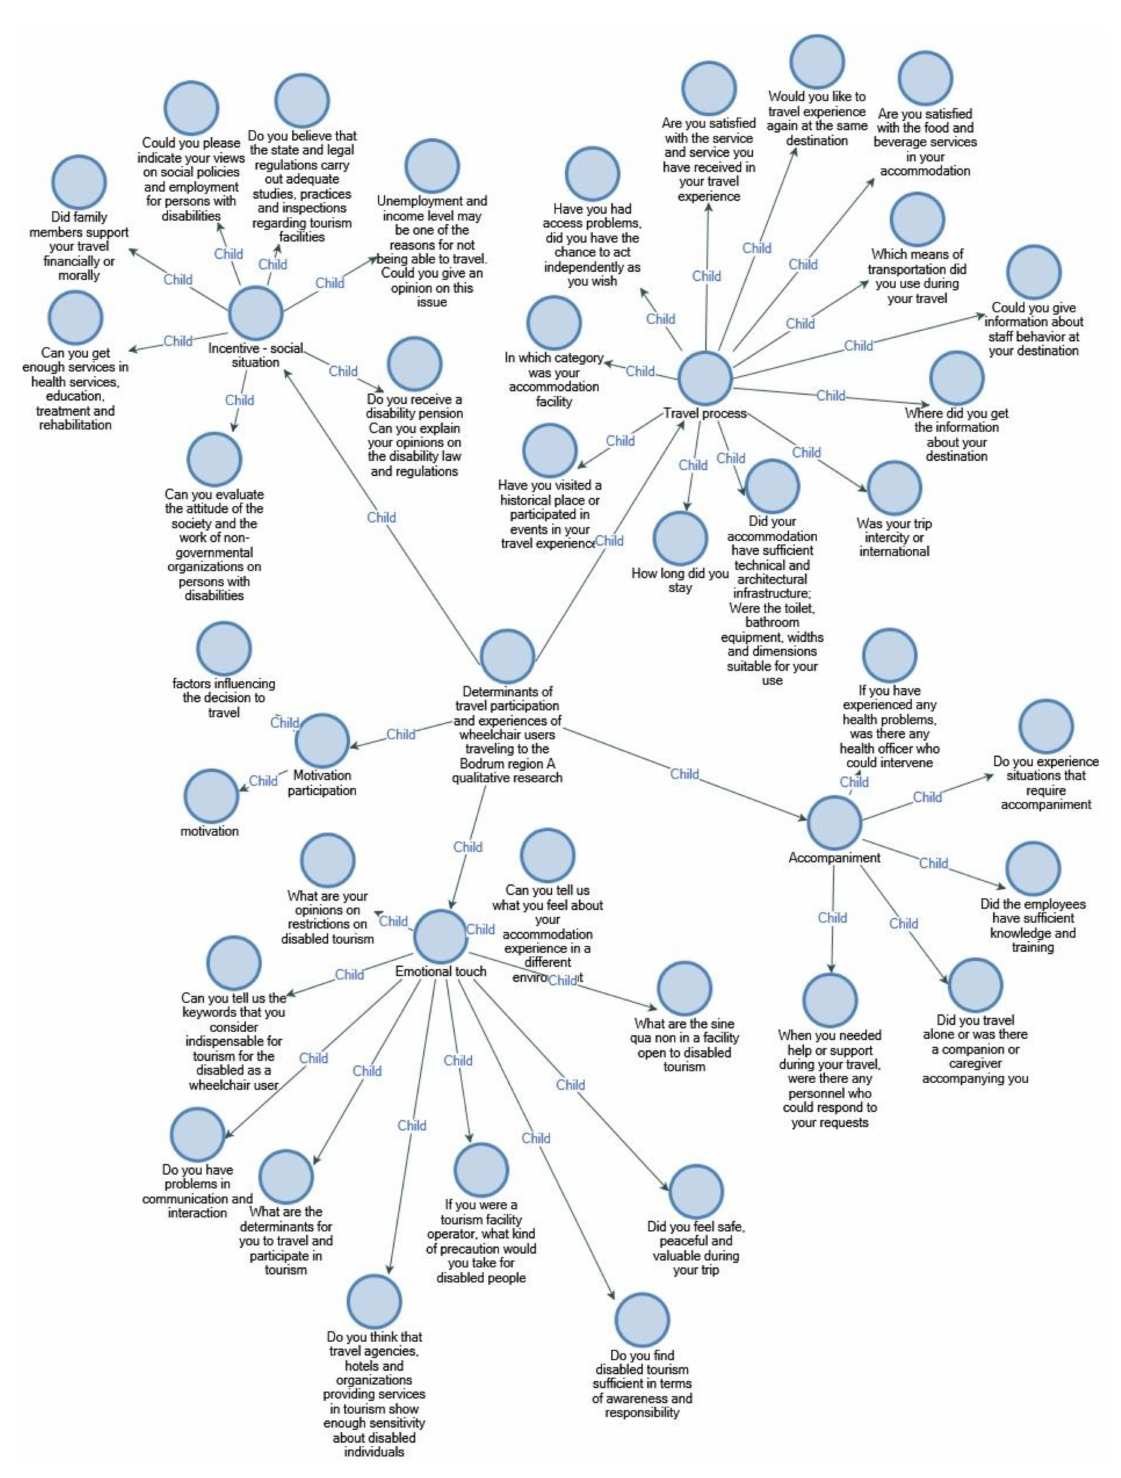
Figure 2. Determinants of travel participation and experiences of wheelchair users